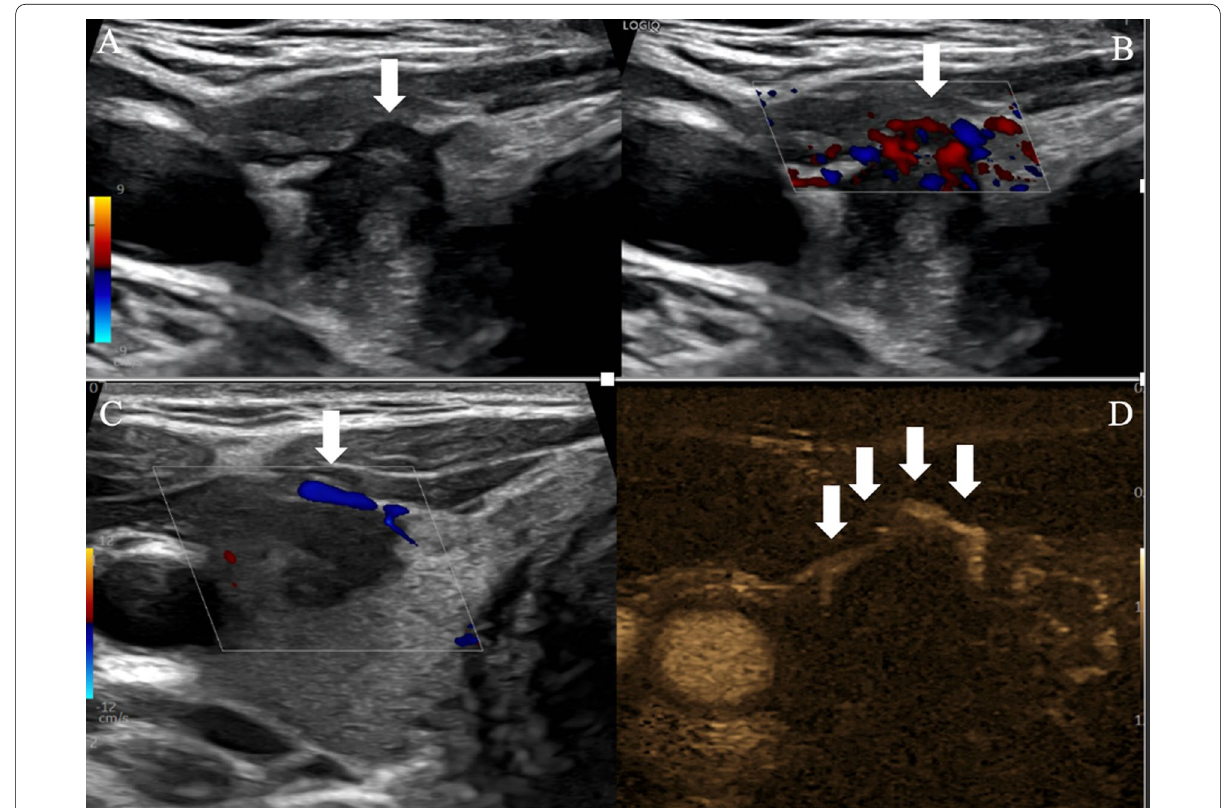
Fig. 3 US assessment of PTC extra thyroid extension (ETE). Axial US scan, grey scale ( A ), colour Doppler ( B , C ), MicroVascular Imaging MVI ( D ) of right lobe PTC. Contour bulging is shown (arrow, A ), neovasculature (arrow) is seen running on the capsula and increases sensitivity of ETE diagnosis ( B ). In case of anterior abutment without disruption ( C , D ), Doppler US discloses vessel (arrow) running along the, while MVI depicts more subtle capsular vessels